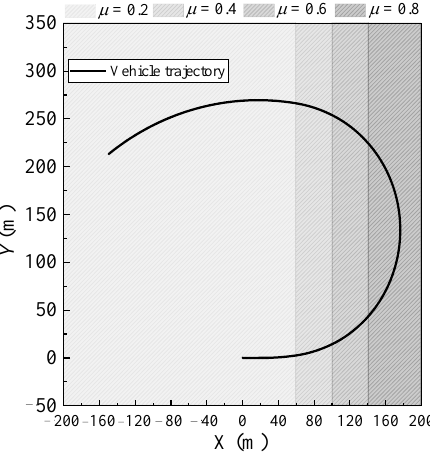
Figure 18. Road map and vehicle trajectory.